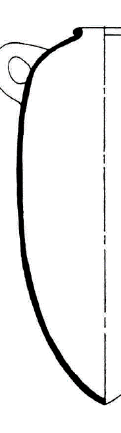
Figure 11. Standardised view of an amphora of type Ramon 2.1.1.1-72. [20].